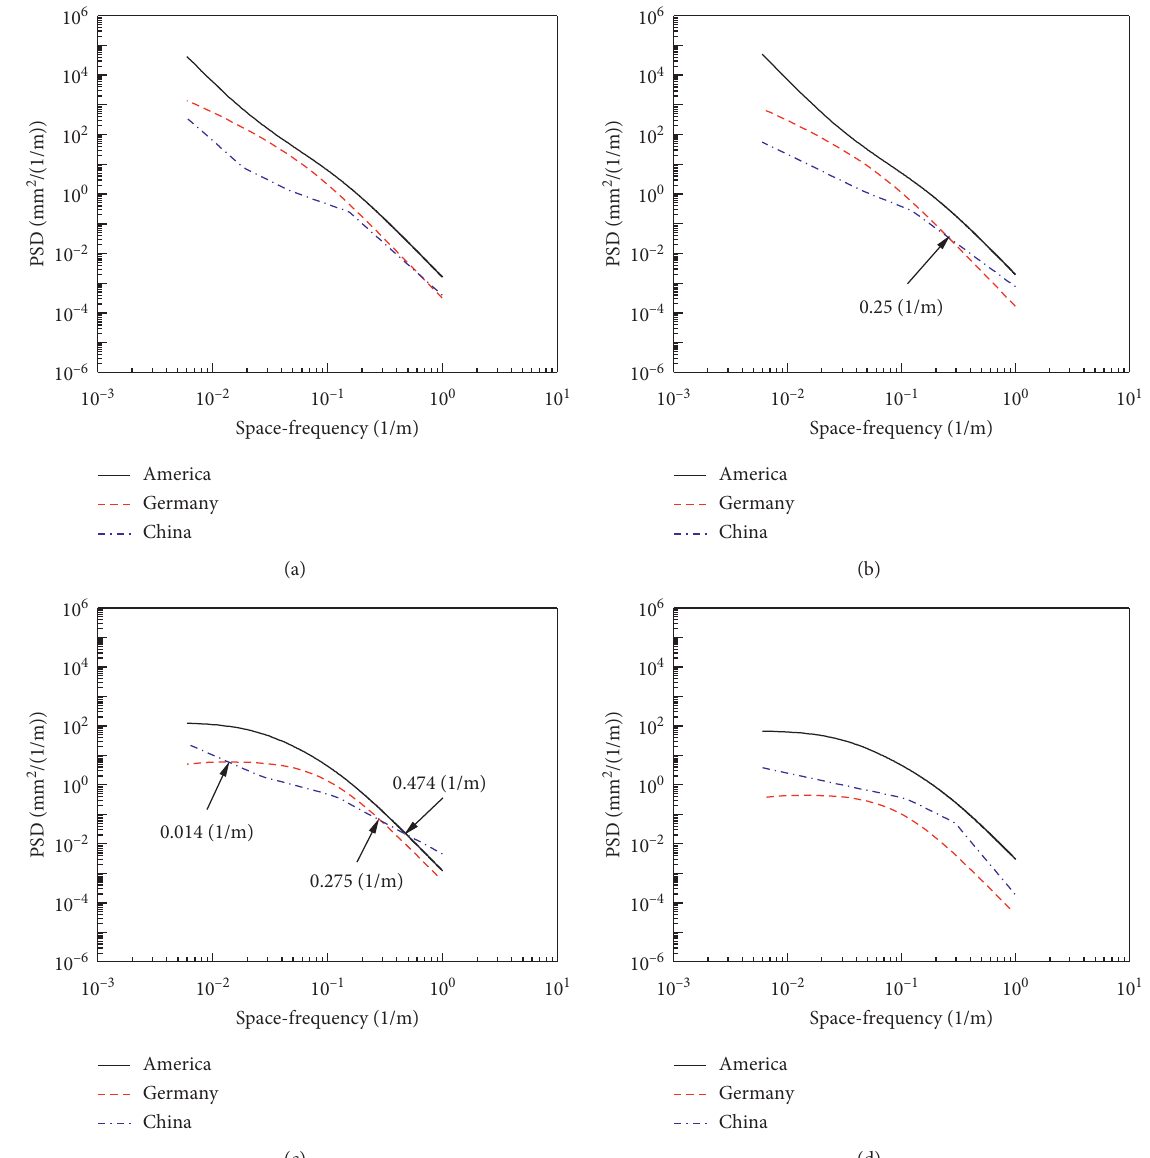
Figure 3: The comparison of PSD for (a) vertical, (b) alignment, (c) cross, and (d) gauge irregularities of